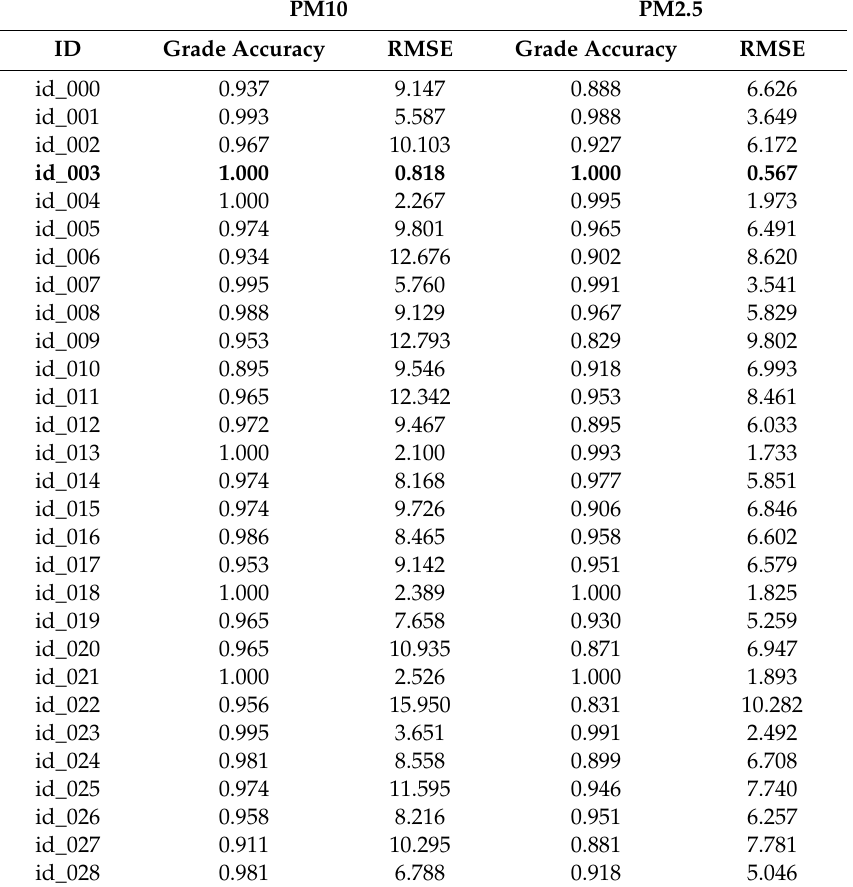
Table 4. Test data results using each model with the first